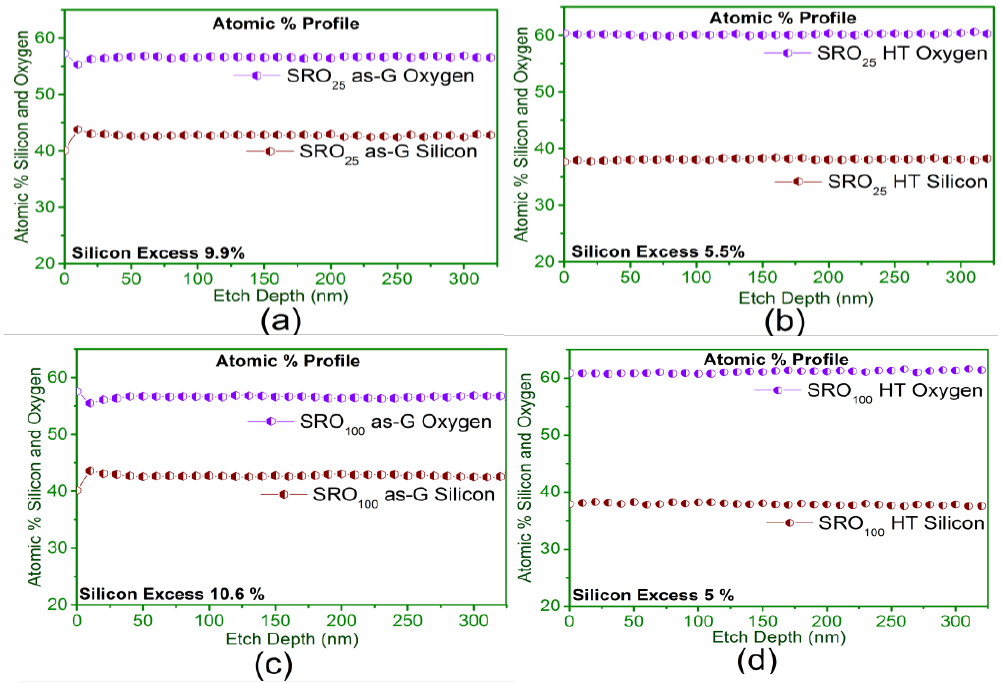
Figure 1. Silicon excess in single-layer SRO 25 and SRO 100 films ( a ) and ( c ) as-G and ( b ) and ( d ) with HT.